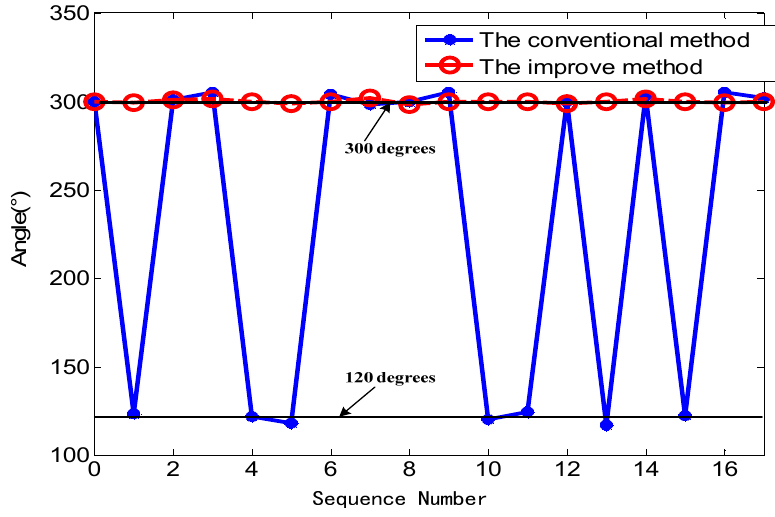
Figure 15. Experimental results of initial electrical rotor position estimation